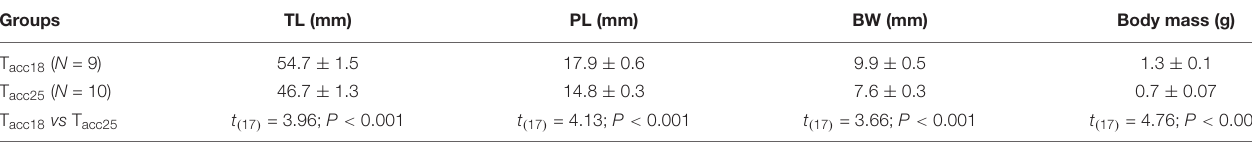
TABLE 1 | Comparisons of body characteristics of tadpoles in different laboratory acclimation groups (T acc18 and T acc25 ◦ C). Groups TL